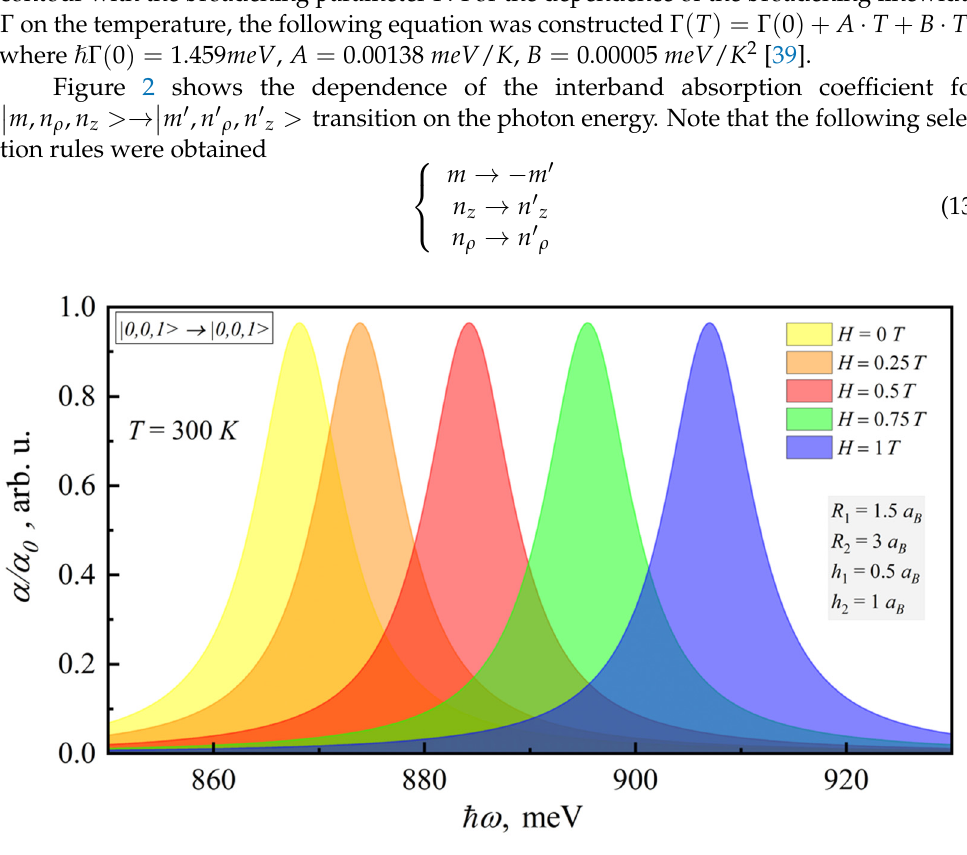
Figure 3. Dependence of the room-temperature interband absorption coefficient on photonenergy for different interband transitions. Figure 4 presents the dependence of the interband absorption coefficient for → 0,0,1 0,0,1 transition on the photon energy for different temperatures (260–300 K ). As can be seen from the figure, interband absorption also increases with temperature for